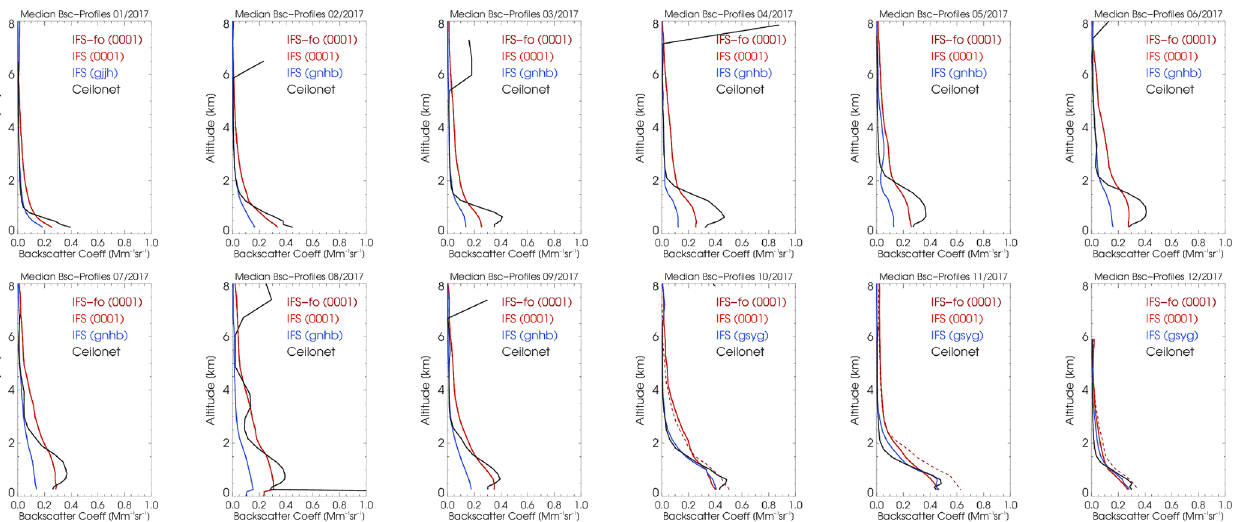
Figure D2. Monthly median profiles 2017 from the ceilometer (black), ASM (red) and control run (blue). The median profile from the IFS forward operator is added as a dashed red